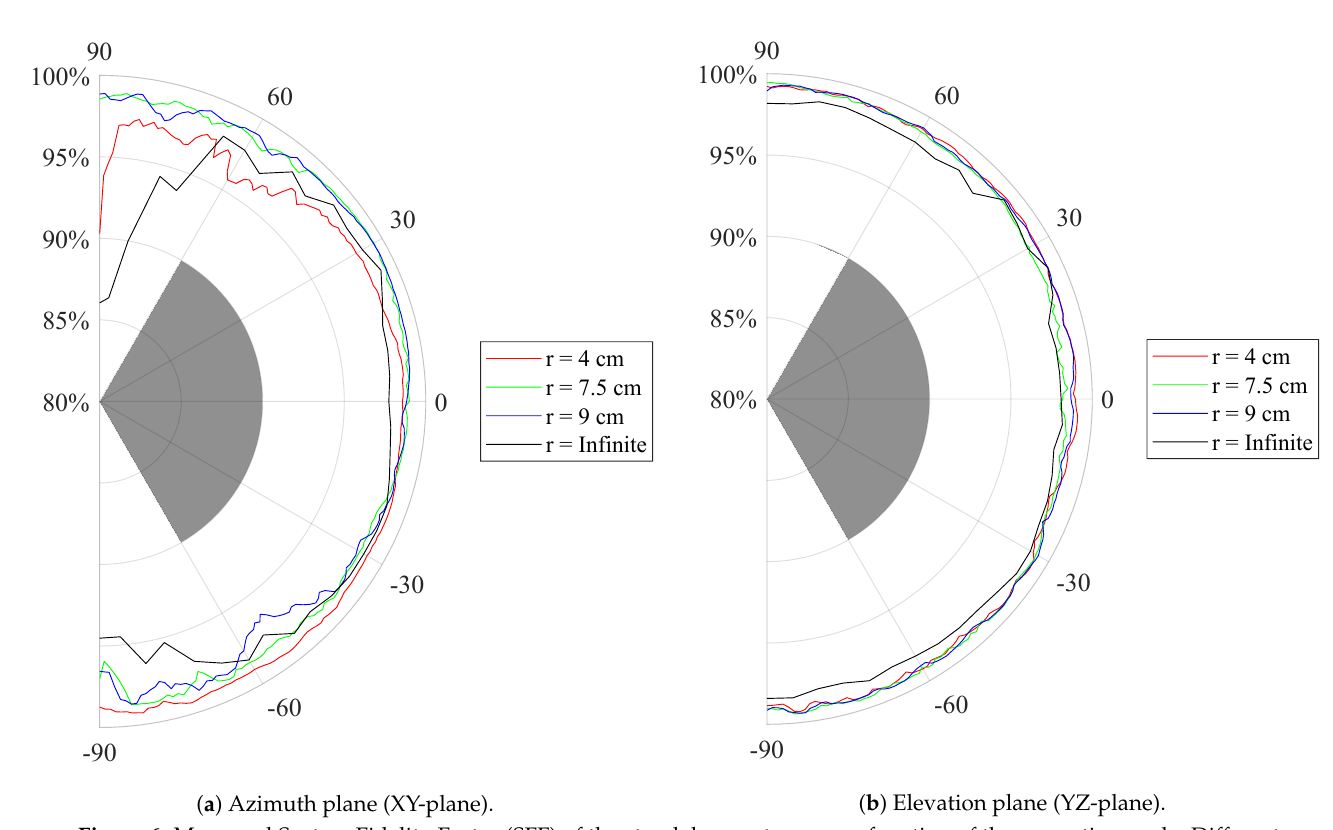
Figure 6. Measured System Fidelity Factor (SFF) of the standalone antenna as a function of the respective angle. Different bending radii r , frequently encountered on the human body, are applied. As a reference, the SFF > 90% goal is marked in grey.